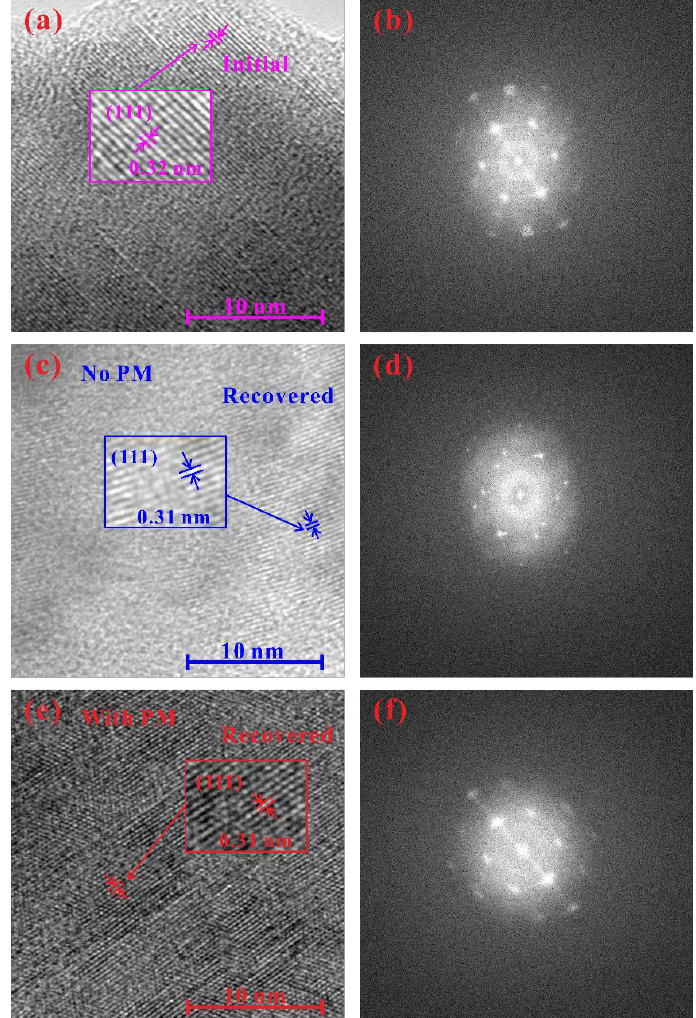
Figure 8. High-resolution transmission electron microscopy (HRTEM) images and their corresponding fast Fourier transform (FFT) patterns for Ga 2 Se 3 . ( a , b ): The images of the initial sample; ( c , d ): The images of the recovered sample decompressed from 39.4 GPa under non-hydrostatic conditions; ( e , f ): The images for the recovered sample decompressed from 39.6 GPa under hydrostatic conditions. Here, PM is the pressure medium.